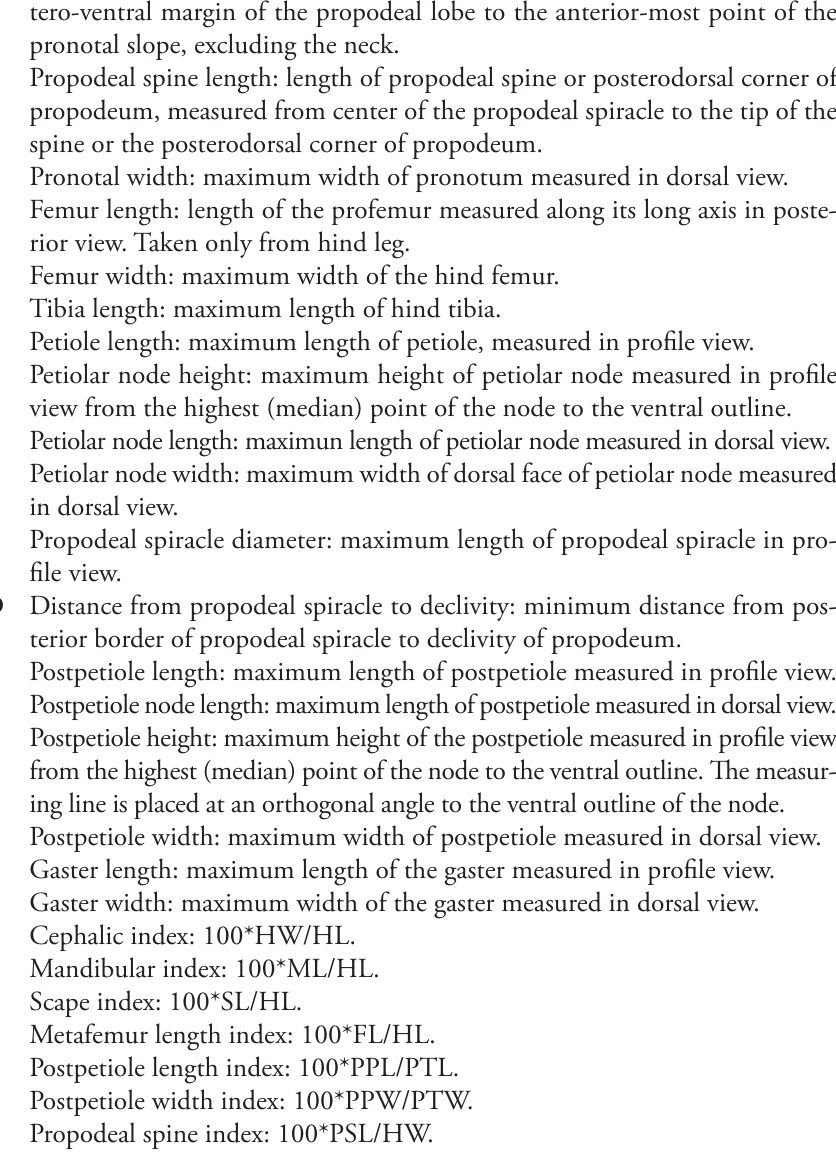
Morphological diagnosis of the worker caste of Carebara (adapted from, and with additions to Fischer et al. 2014). worker caste into smaller workers (minor worker) and larger workers (major